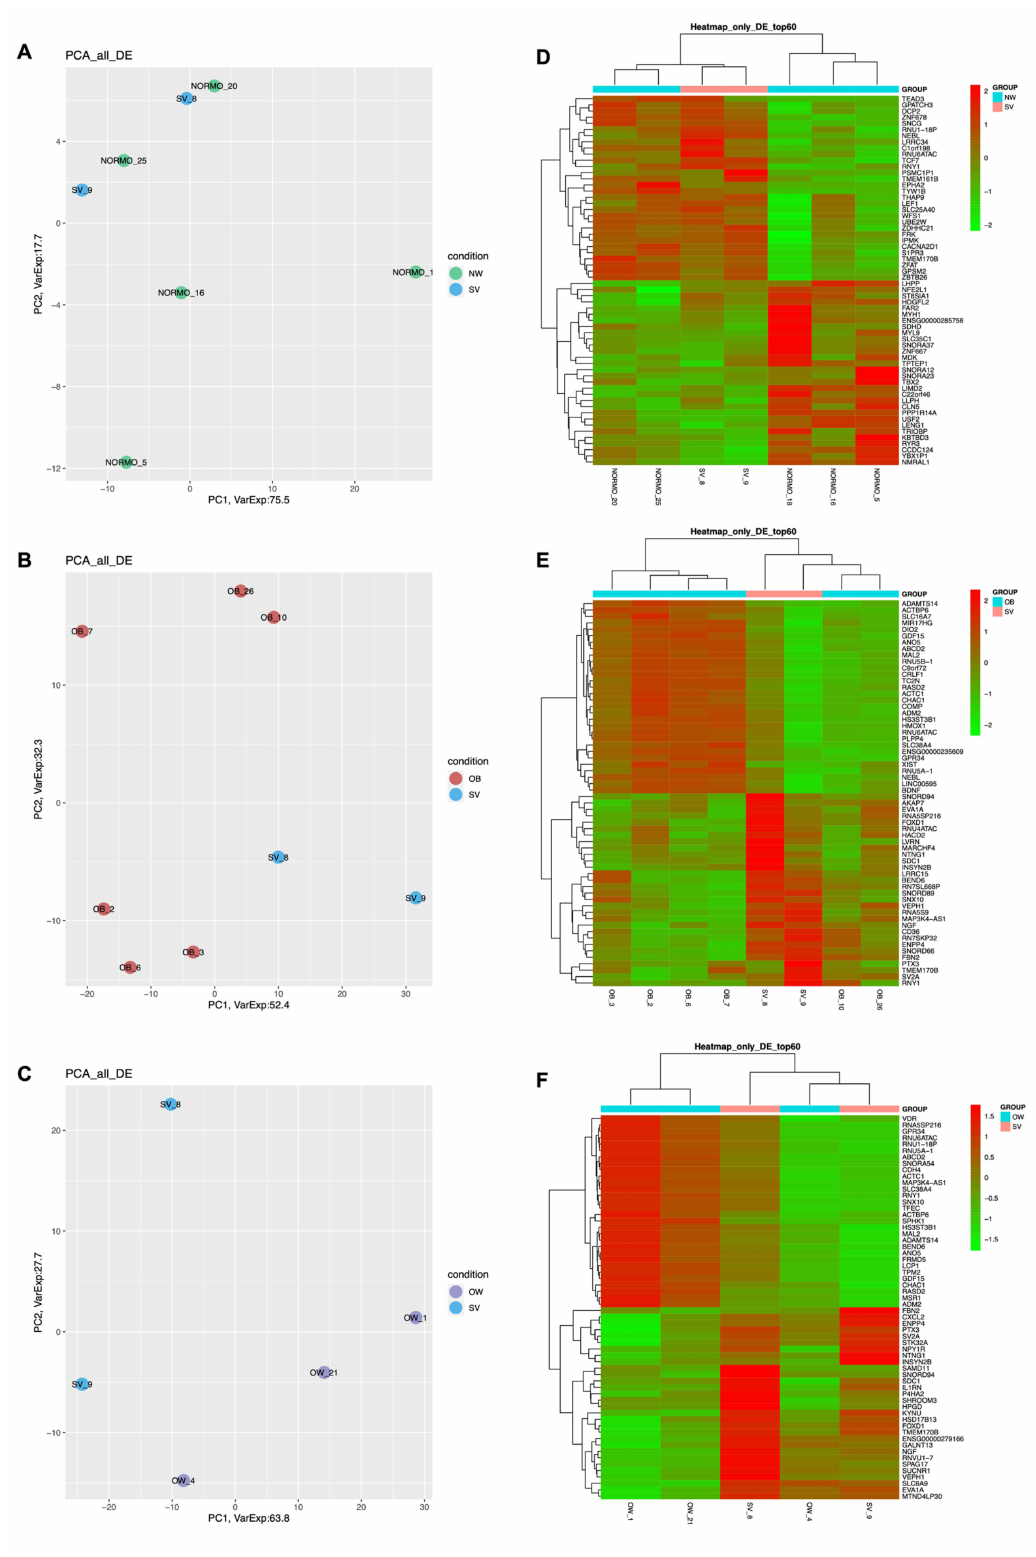
Figure 1. Gene expression profiling. ( A – C ): PCA plots obtained from the three comparisons SV vs. NW, SV vs. OB, and SV vs. OW; ( D – F ): Heatmaps of SV vs. NW, SV vs. OB, and SV vs. OW. Green: downregulated DEGs; red: upregulated